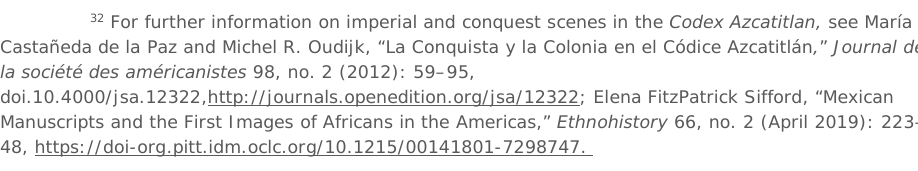
through Mexico) as is the juxtaposition of different temporal and spatial moments (Fig. 6). 33 Here, Garcilazo portrays a former president and drug leader in Axayácatl’s teptzoicpalli and, instead of Moquihuix’s defeat, depicts the massacre of student activists in Mexico as well as trucks used for the transportation and trafficking of drugs and migrants.